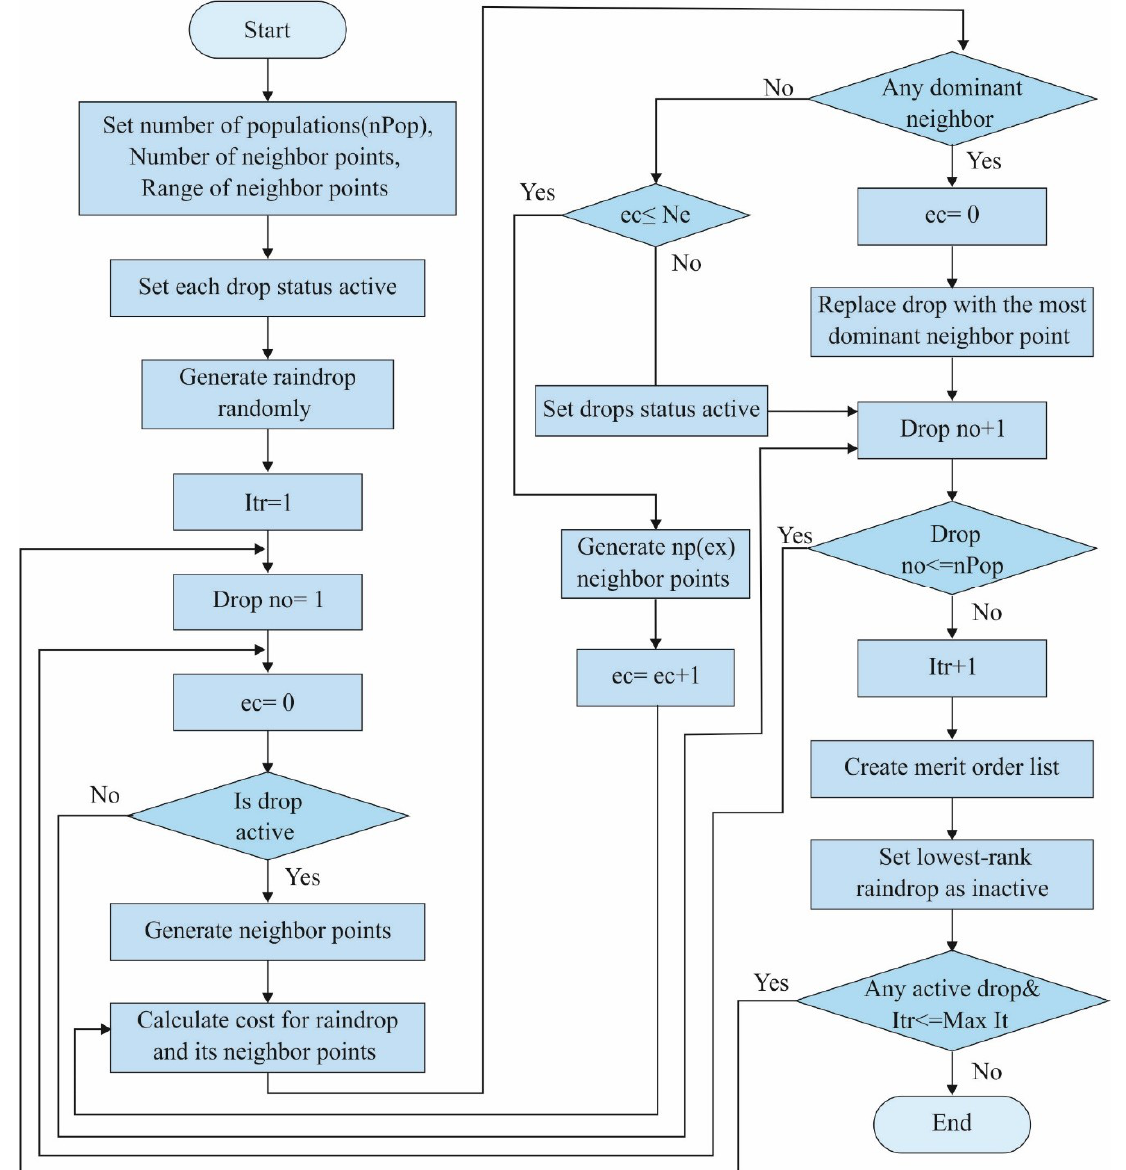
Figure 3. Flowchart of the rain drop optimization (RFO) algorithm.